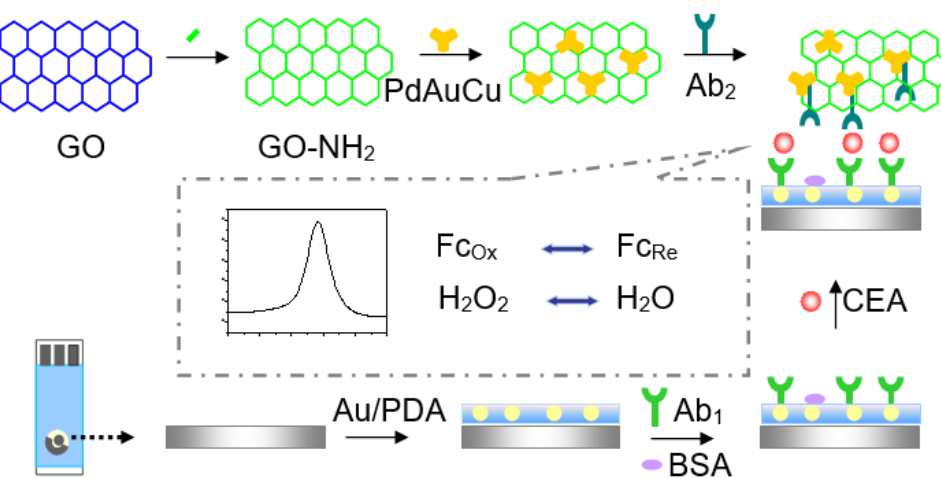
Figure 1. The schematic illustration of the fabrication procedure of the CEA immunosensor.